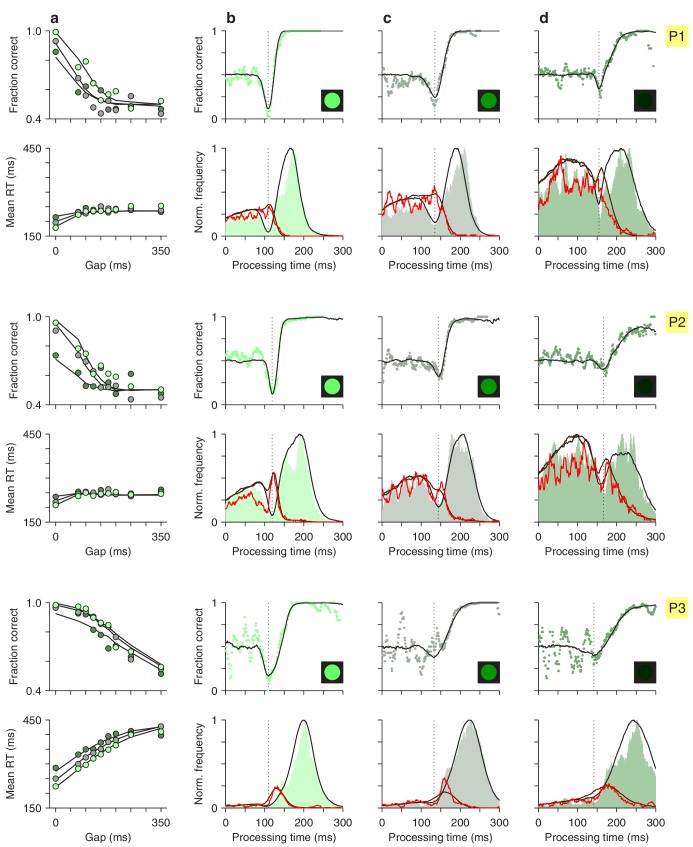
The accelerated race-to-threshold model individually fitted to the data of participants 1 (top two rows), 2 (middle rows), and 3 (bottom two rows), as indicated on the right.(a) Mean fraction of correct choices (top) and mean RT (bottom) as functions of gap. Circles are experimental results for high (bright green), medium (grayish green), and low luminance (dark green) conditions. Continuous lines are model results. (b–d), Tachometric curves for high (b), medium (c), and low luminance cues (d) are shown in the top panels. Corresponding rPT distributions for correct (shades) and incorrect trials (red traces) are shown in the bottom panels. Black and dark-red continuous lines are model results. For each luminance, the dotted vertical line marks the vortex time.